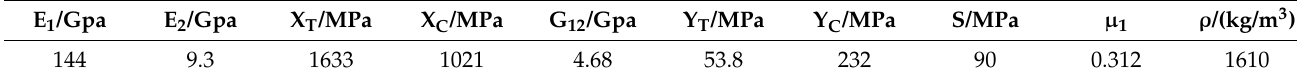
Table 1. Mechanical properties of T300 epoxy resin carbon fibre.